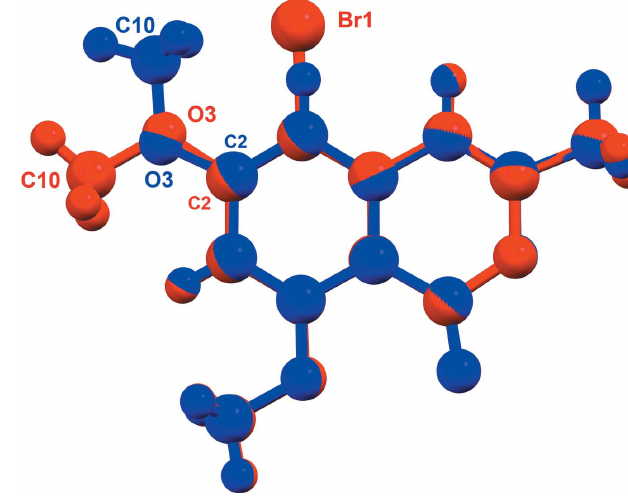
Figure 3 The structural overlap of compounds I (blue) and II (red); r.m.s. deviation = 0.0107 A˚ ( Mercury ; Macrae et al. ,